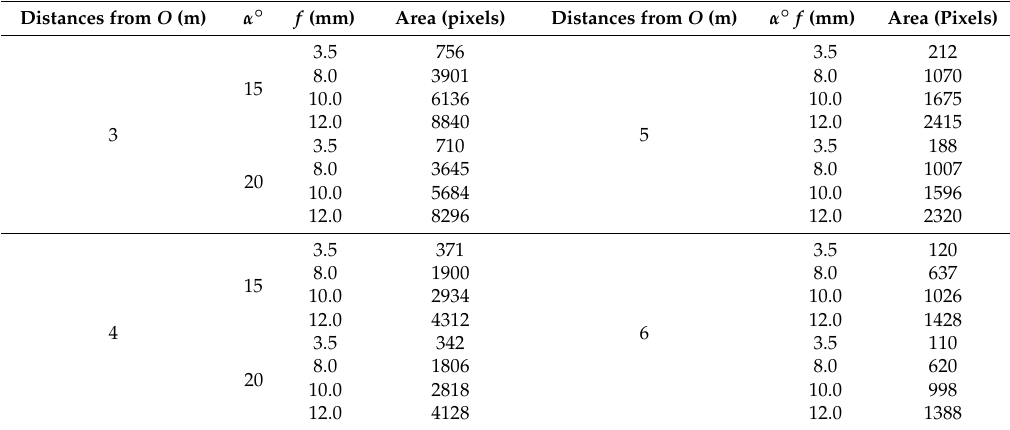
Table 3. Imaged areas in pixels for a patch of 20 × 20 cm 2 at different distances form the origin in the coordinates of the world system, α angles and focal lengths.